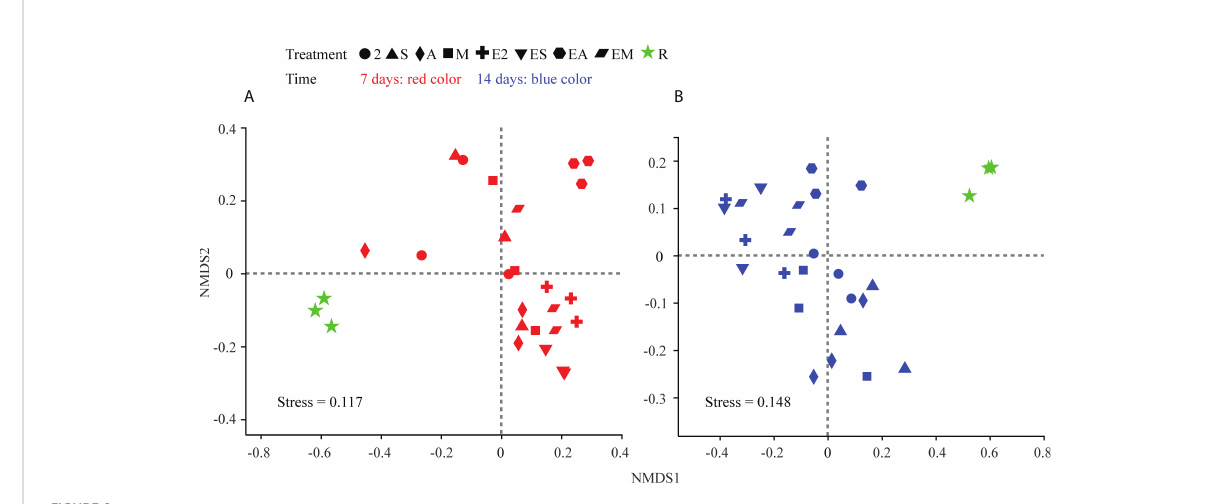
FIGURE 9 NMDS ordinations based on weighted UniFrac distance matrices of bacterial communities in chemoattractant and chemoattractant-plus- chemotactic strain treatments at 7 (A) and 14 (B) days and in rhizosphere soils of a C. equisetifolia